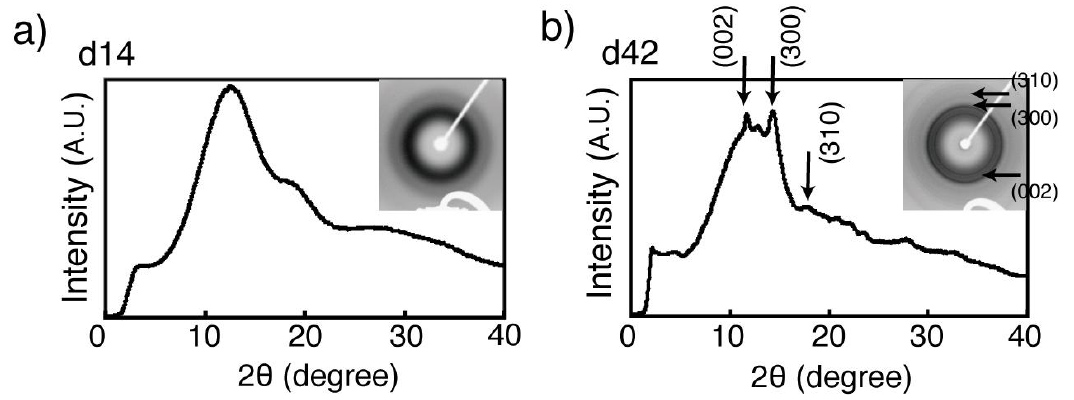
Figure 6. X-ray diffraction (XRD) profiles of obtained mineral in 3D construct at ( a ) day 14 and ( b ) at day 42.